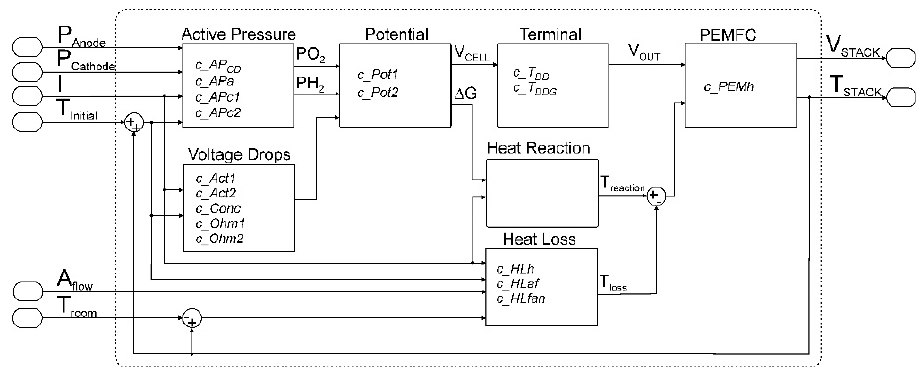
Figure 3. PEMFC model.